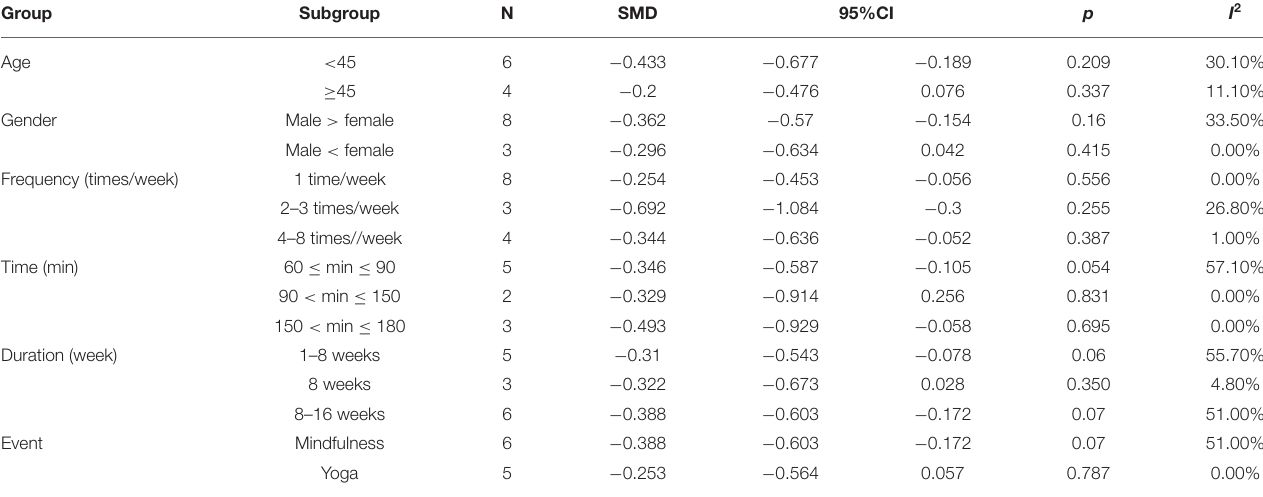
TABLE 6 | Sub-group analysis of depression in patients with PTSD. Group